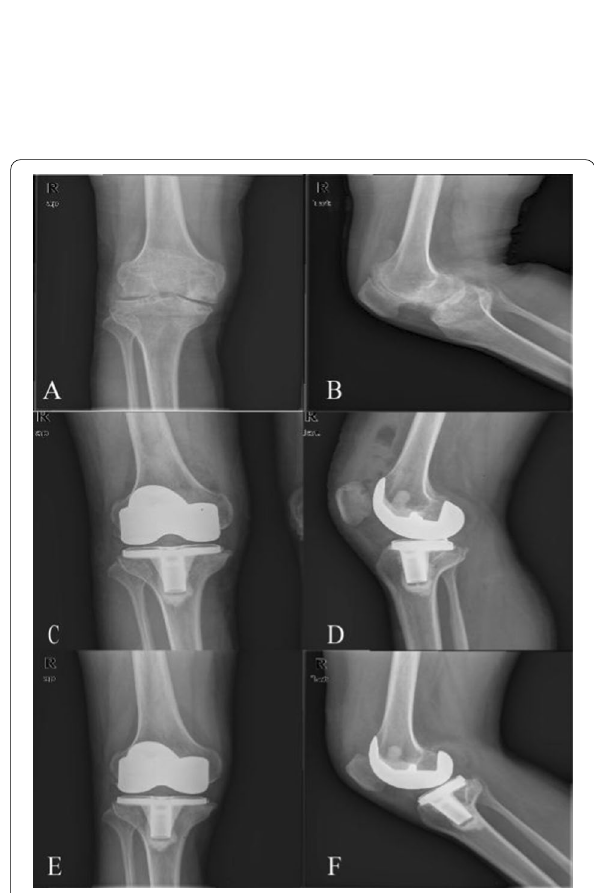
Fig. 5 Radiographs of a 35-year-old male patient with severe haemophilic arthropathy. Preoperative X-rays showed extensive destruction of an articular surface, narrowing of the joint space, and a square patella. A Preoperative anteroposterior radiograph.